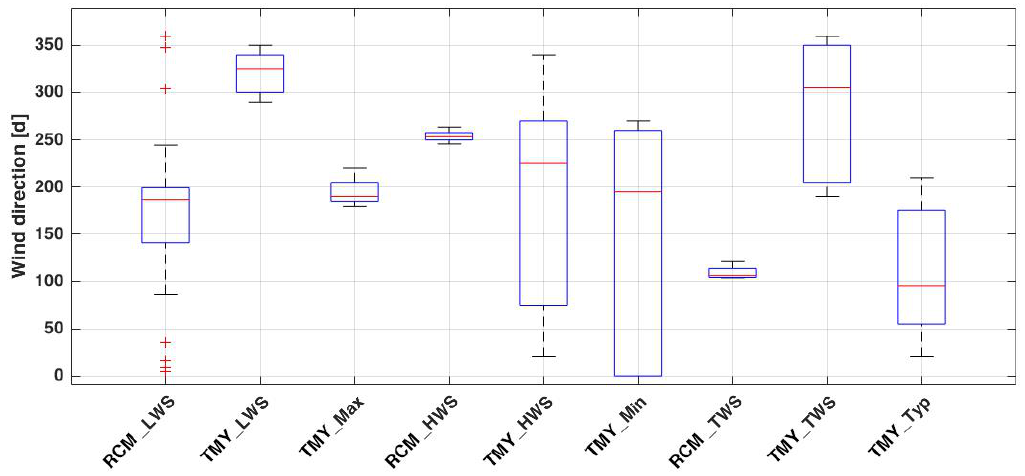
Figure 2. Wind direction frequency in the generated weather datasets. Table 1. The details of fifteen generated weather datasets in the study for energy performance simulations (EPS); mesoscale data: regional climate models (RCM) and typical meteorological year (TMY), microscale data: micro in typical and extreme low and high wind conditions.